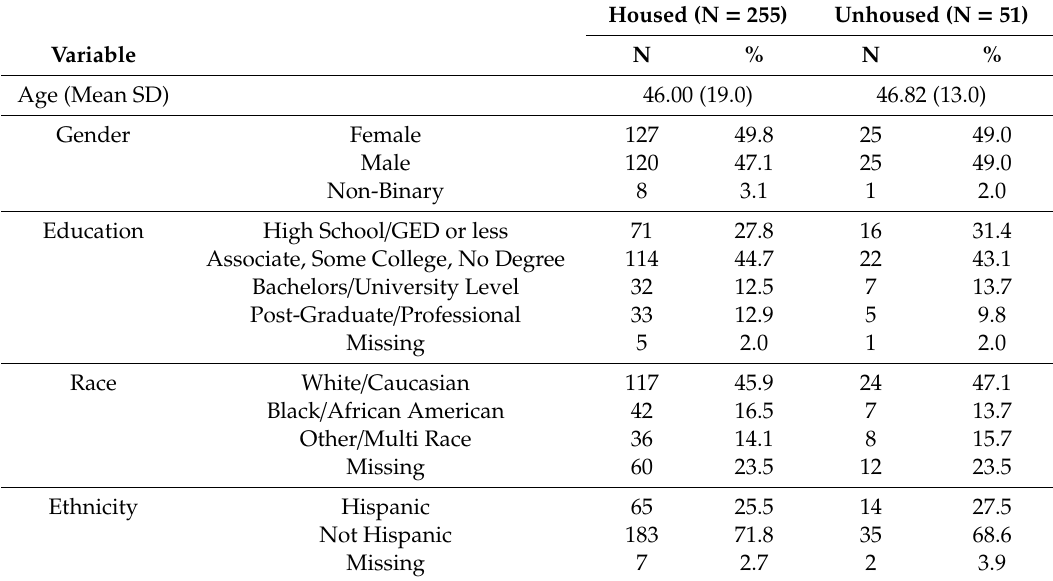
Table 2. Demographics of the matched housed and unhoused